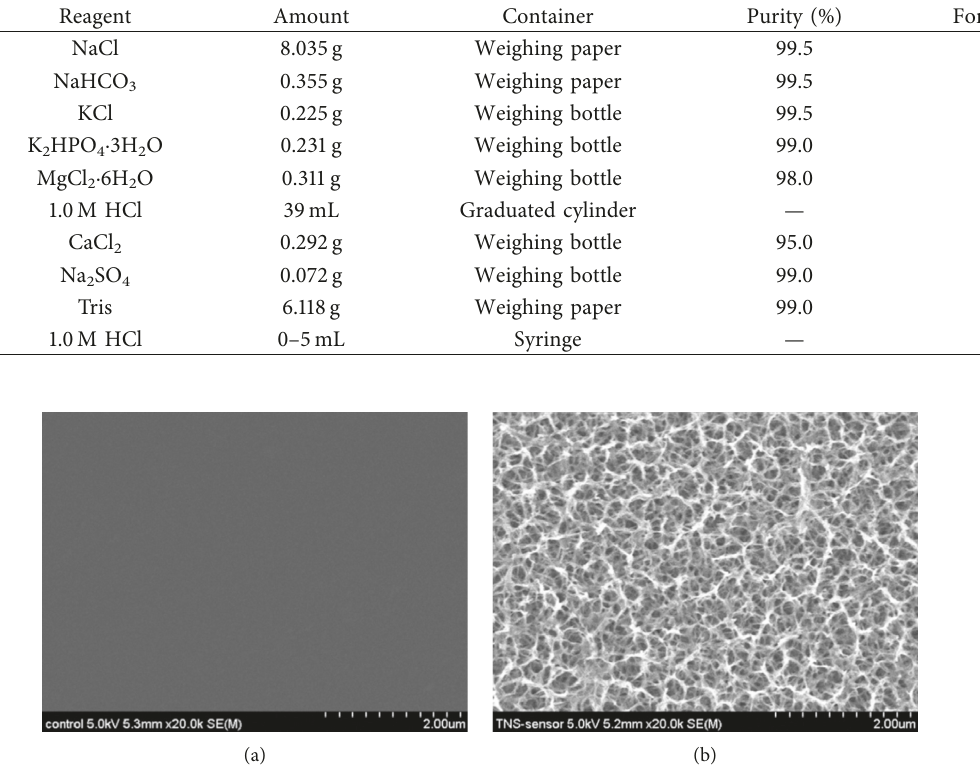
Figure 1: SEM images of (a) Ti and (b) TNS QCM sensors.